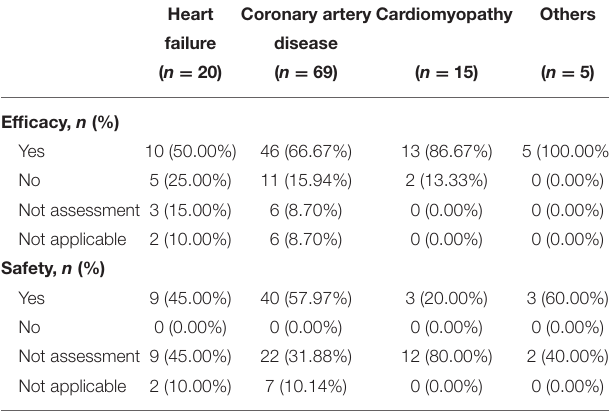
TABLE 9 | Efficacy and safety of stem cell therapy for heart